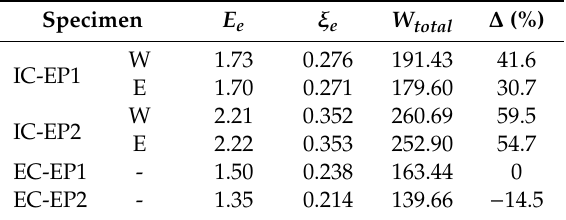
Table Note: E e , ξ e , and W total are the energy dissipation coe ffi cient, the equivalent viscous damping coe ffi cient, and the total dissipated energy, respectively, ∆ represents the relative di ff erence. Table 6 compares the energy dissipation capacity ( E e ), equivalent viscous damping coe ffi cient ( ξ e ), and total energy dissipation ( W total ) in the limit state. Figure 14 exhibits the equivalent